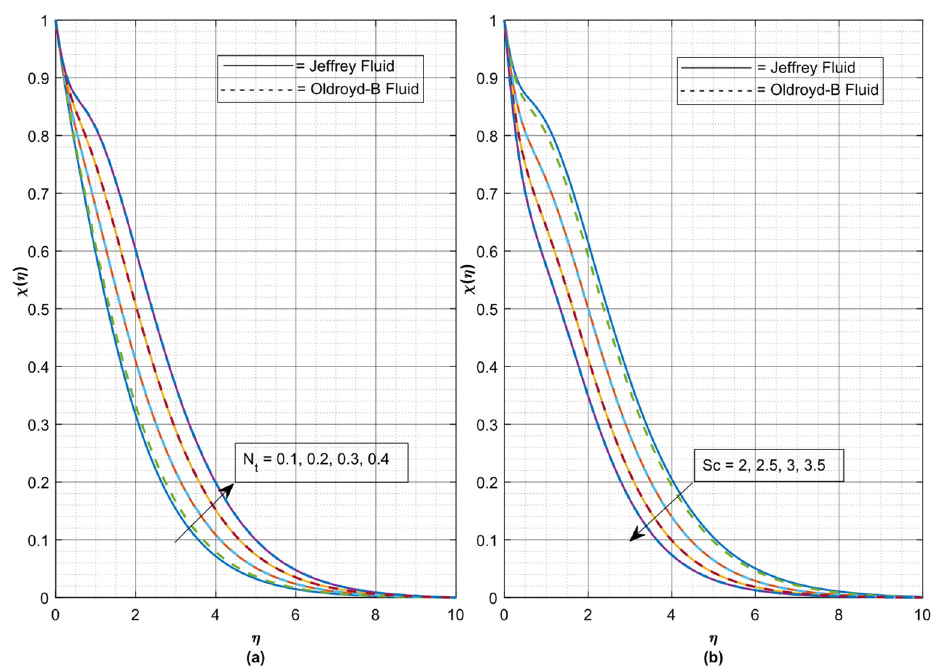
( ) χ η ( ) χ η Figure 7. ( a ) Impact of N t on χ ( η ) and ( b ) Impact of Sc on χ ( η ) . Figure 7. (a) Impact of t N on and (b) Impact of Sc on . The impact of N t on Re − 1/2 Nu f versus γ for both liquids is exemplified in Figure 8a. Nu − versus γ for both liquids is exemplified in N on 1/2 Re The escalating values of N t deteriorations the Re − 1/2 Nu f of both liquids, but a contrary The impact of f t trend is seen for improved γ values. Moreover, Oldroyd-B liquid shows a slightly im- N deteriorations the 1/2 Re Nu − of both liquids, Figure 8a. The escalating values of t proved fluid phase heat transfer rate compared to Jeffrey liquid for growing values of N t . f γ values. Moreover, Oldroyd-B liquid shows a but a contrary trend is seen for improved The encouragement of N t on Re − 1/2 Nu s versus γ for both nanoliquids is exemplified in Figure 8b. The escalating values of N t declines the Re − 1/2 Nu s of both liquids. However, slightly improved fluid phase heat transfer rate compared to Jeffrey liquid for growing inverse movement is seen for improved values of γ . Moreover, Jeffrey liquid shows im- N . The encouragement of N on 1/2 Re Nu − versus γ for both nanoliquids values of t t s proved solid phase heat transfer rate compared to Oldroyd-B liquid for growing values of N declines the 1/2 Re Nu − of both is exemplified in Figure 8b. The escalating values of both N t and γ . From Figure 8a,b we conclude that, an upsurge in the H leads to growth t s γ in the solid phase heat transfer rate of Jeffrey liquid while it declines the fluid phase heat liquids. However, inverse movement is seen for improved values of . Moreover, Jeffrey transference rate of Jeffrey fluid. Figure 9a depicts the impact of M on Re 1/2 C f versus K ∗∗ liquid shows improved solid phase heat transfer rate compared to Oldroyd-B liquid for for both liquids. The escalating values of M and K ∗∗ decays the Re 1/2 C f of both liquids. N and γ . From Figures 8(a) and 8(b) we conclude that, an growing values of both t Moreover, Re 1/2 C f for Jeffrey liquid declines faster than that of the Oldroyd-B liquid. The upsurge in the H leads to growth in the solid phase heat transfer rate of Jeffrey liquid change in ShRe − 1/2 versus Sc for escalating values of N b for both liquids is revealed in while it declines the fluid phase heat transference rate of Jeffrey fluid. Figure 9a depicts Figure 9b. Here, ShRe − 1/2 improves for booming values of both N b and Sc . C versus ** K for both liquids. The escalating values of the impact of M on 1/2 Re f M and ** K decays the 1/2 Re C of both liquids. Moreover, 1/2 Re C for Jeffrey f f liquid declines faster than that of the Oldroyd-B liquid. The change in 𝑆ℎ𝑅𝑒 (cid:2879)(cid:2869)/(cid:2870) versus N for both liquids is revealed in Figure 9b. Here, Sc for escalating values of b N and Sc . Moreover, Jeffrey liquid 𝑆ℎ𝑅𝑒 (cid:2879)(cid:2869)/(cid:2870) improves for booming values of both b shows more mass transfer rate than that of the Oldroyd-B liquid for rising values of both b N and Sc .